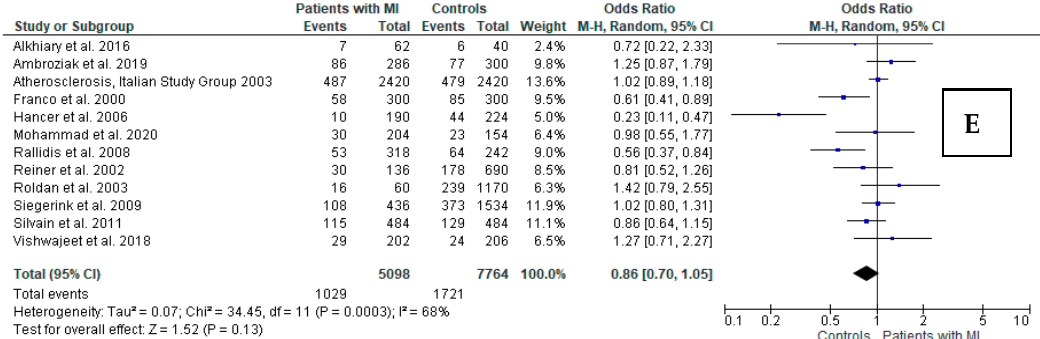
Figure 3. Forest plots for relations between different genetic models of FXIII polymorphism and myocardial infarction in total groups of young patients: ( A ) Val/Leu + Leu/Leu vs. Val/Val; ( B ) Leu/Leu vs. Val/Leu + Val/Val; ( C ) Leu/Leu vs. Val/Val; ( D ) Val/Leu vs. Val/Val; ( E ) Leu vs. Val. M-H: Mantel–Haenszel; CI: confidence interval; I 2 : heterogeneity; df: degrees of freedom [10,12,13,29–38].